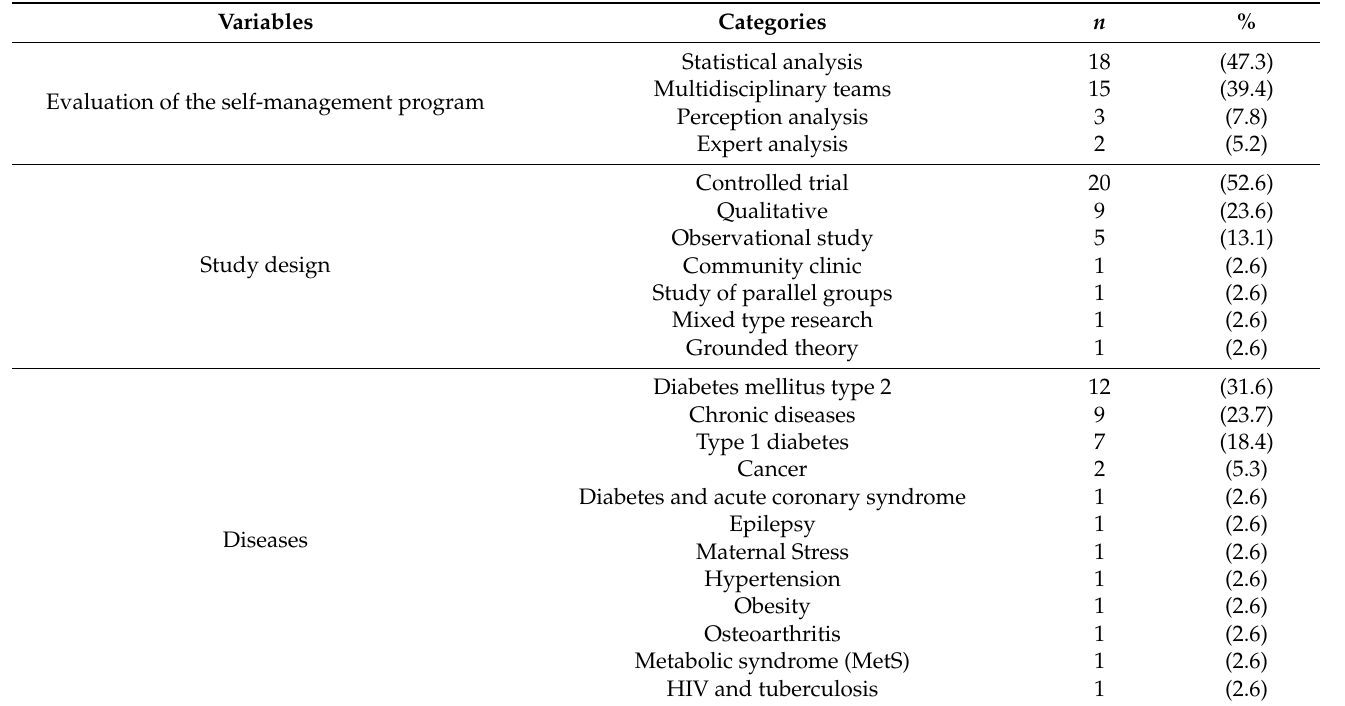
Table 1. General characteristics of the included studies ( n = 38).